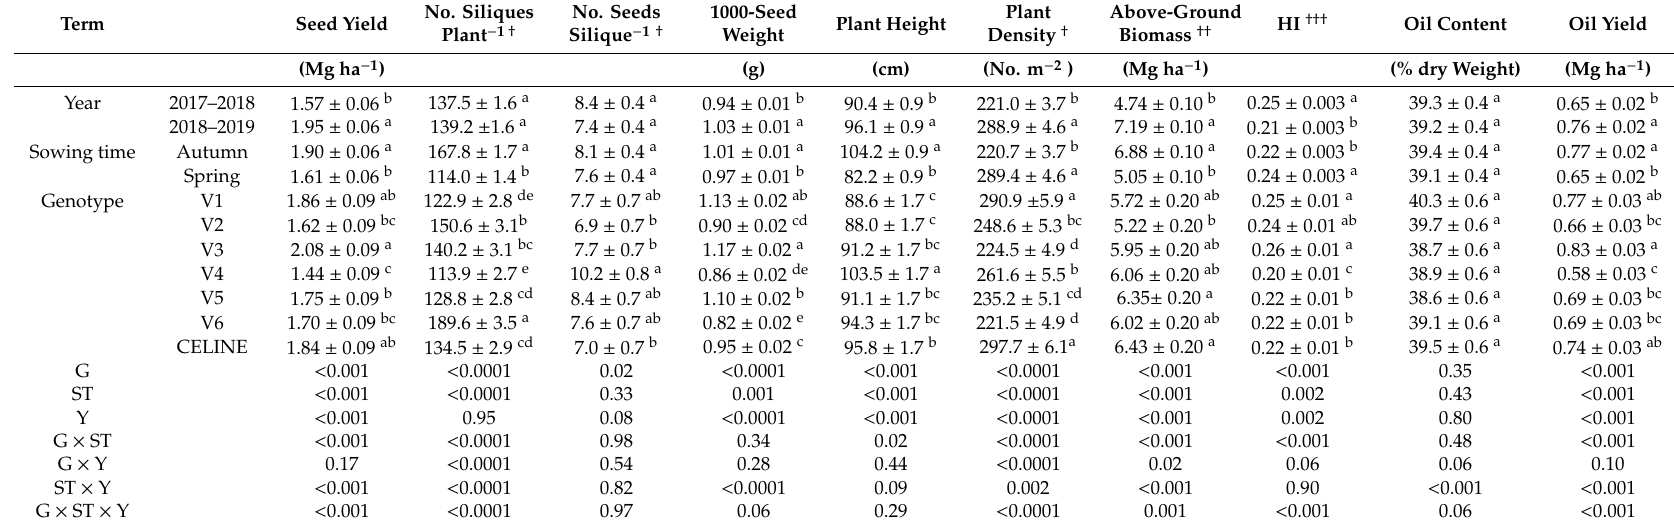
Table 3. Main e ff ects of year (Y), sowing time (ST), and genotype (G) and their interaction on camelina production traits and p -values of the analysis of variance.